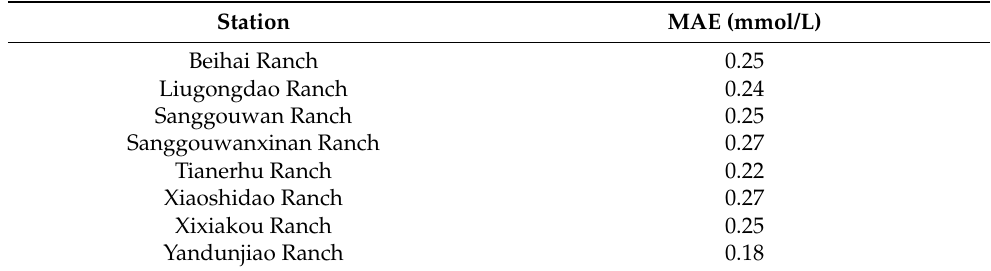
Table 2. The mean absolute error (MAE) between simulated and observed chlorophyll-a concentration in different